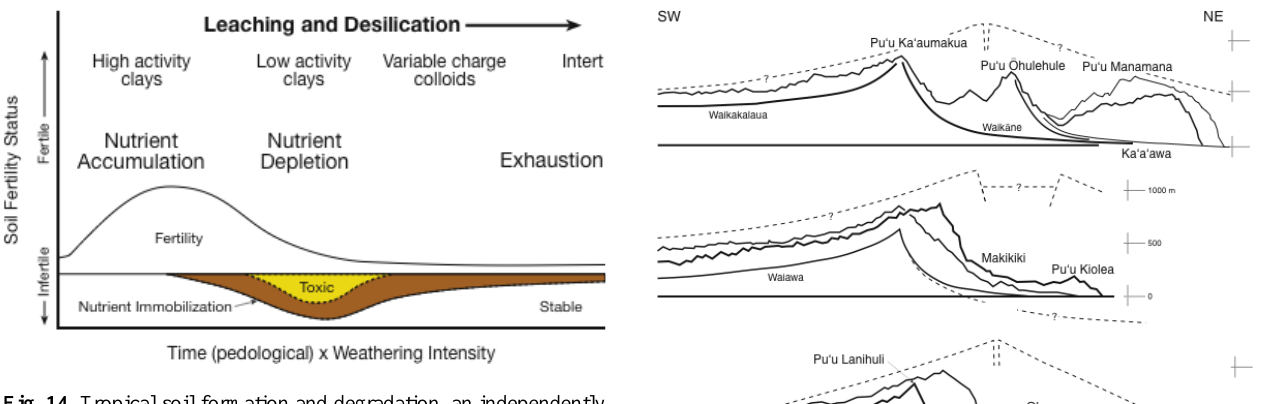
Fig. 14. Tropical soil formation and degradation, an independently designed conceptual model that matches the long-term primary successional model shown in Fig. 12 above. From Fox et al. (1991) with permission from Allertonia, a journal of the National Tropical Botanic Garden on Kaua‘i Island. 685